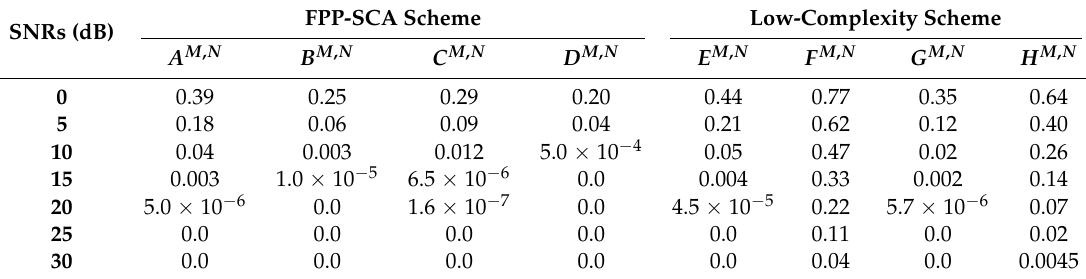
Figure 5. The antennas versus SNR for 50 iterations. Table 4. The effects of antennas